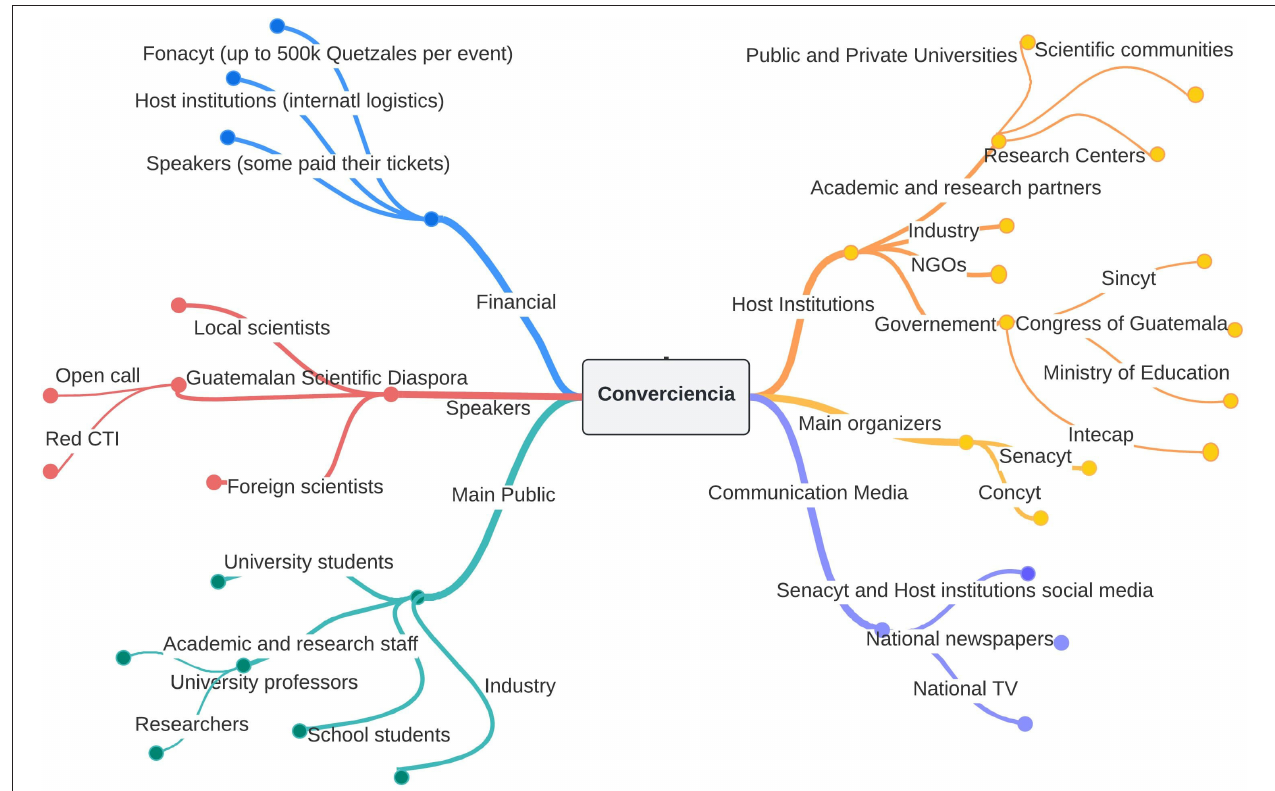
FIGURE 1 | Actors in Converciencia : descriptive analysis. Source: own elaboration.